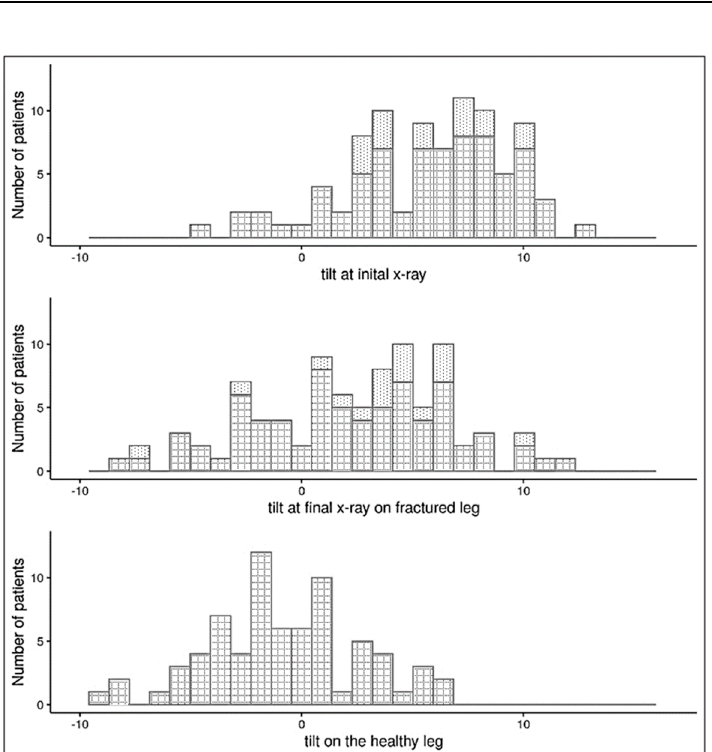
Figure 3. Anterior tilt angles of the proximal tibia in fractured and healthy legs of children with trampoline fractures. The fractured legs were measured in the initial x-ray, taken at the time of the injury, and final x-rays were taken at least one year later. The tilt scale ranges from rather normal (negative) to rather pathological (positive) values. Dotted bars : children without an x-ray of the healthy leg (17/89 patients); checked bars : children with an x-ray of the healthy leg at the final examination (72/89 patients). Table 1. Measurements of anterior tilt angles after trampoline fracture in our study population (N = 89) on the day of the injury and one year after trauma.